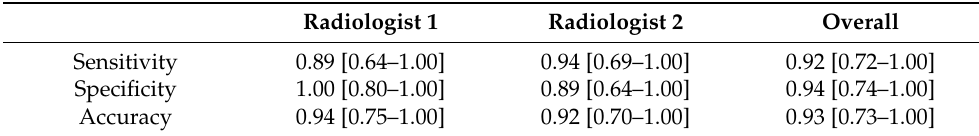
Table 2. Diagnostic performance of dual-layer spectral CT over all patients for the detection of BME with MR imaging as standard of reference. Sensitivity, specificity, and accuracy are given with 95% confidence interval.